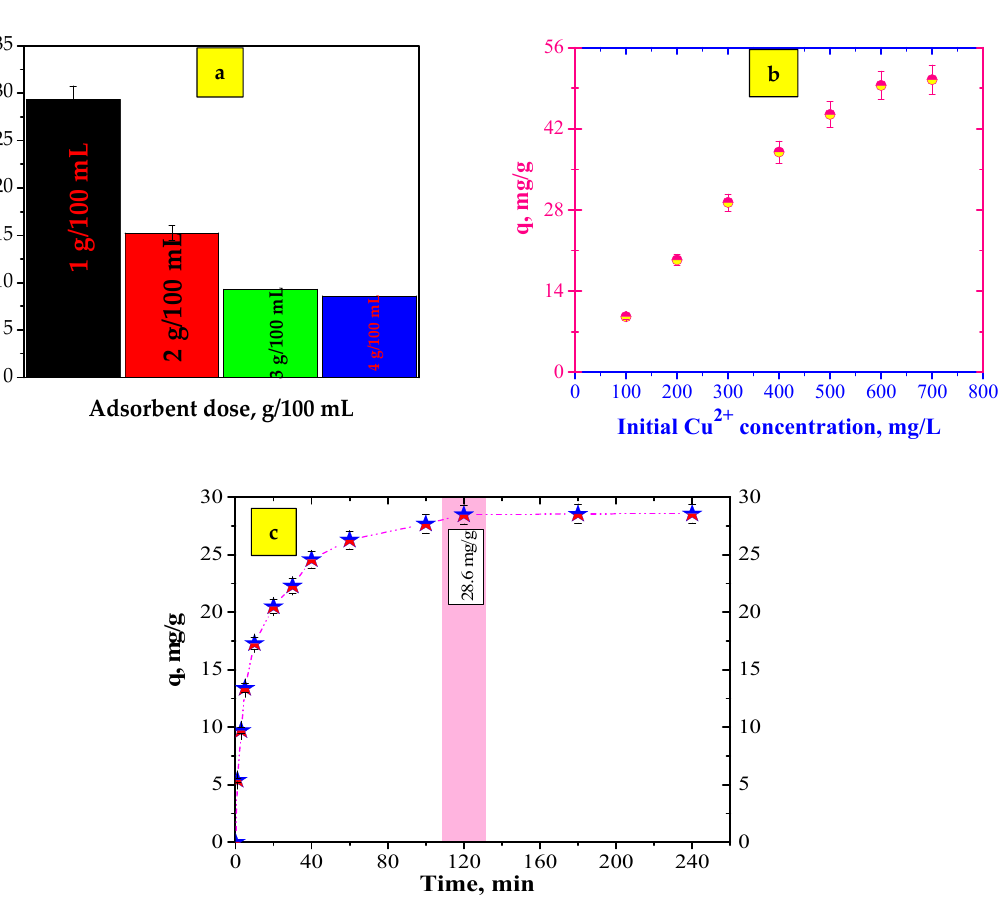
Figure 4. ( a ) Influence of adsorbent dose (pH, 5.0; contact time, 24 h; initial Cu 2+ concentration, 300 mg/L; temperature,